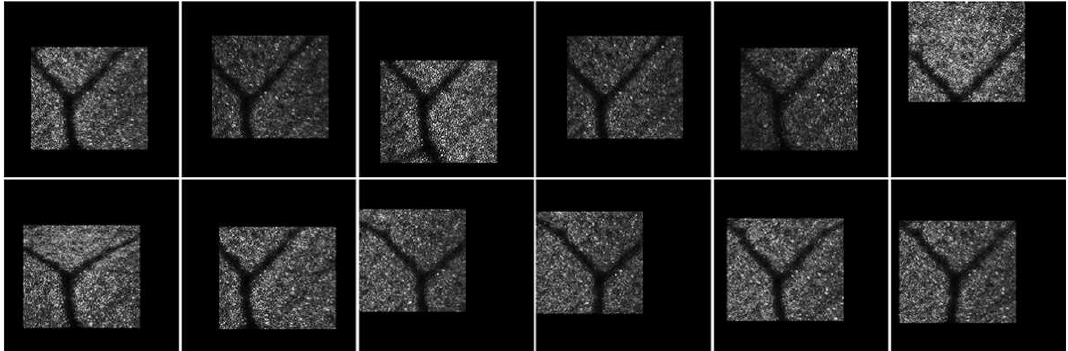
Figure 14. AOSLO image stabilization results under saccadic eye motion. The first image is the first frame in the sequence.